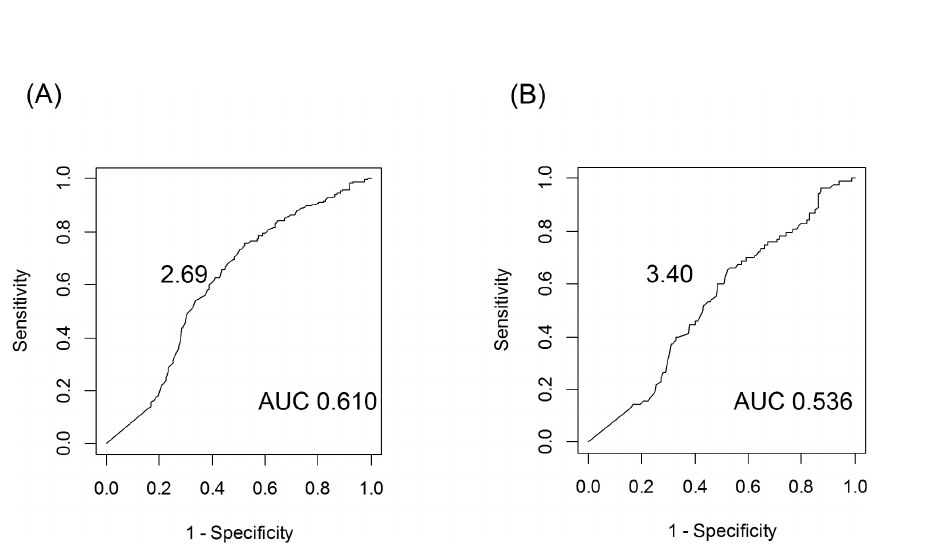
Fig 2. Cut-off values of SUV max in prediction of EGFR and KRAS mutation. (A) EGFR mutation, (B) KRAS mutation.